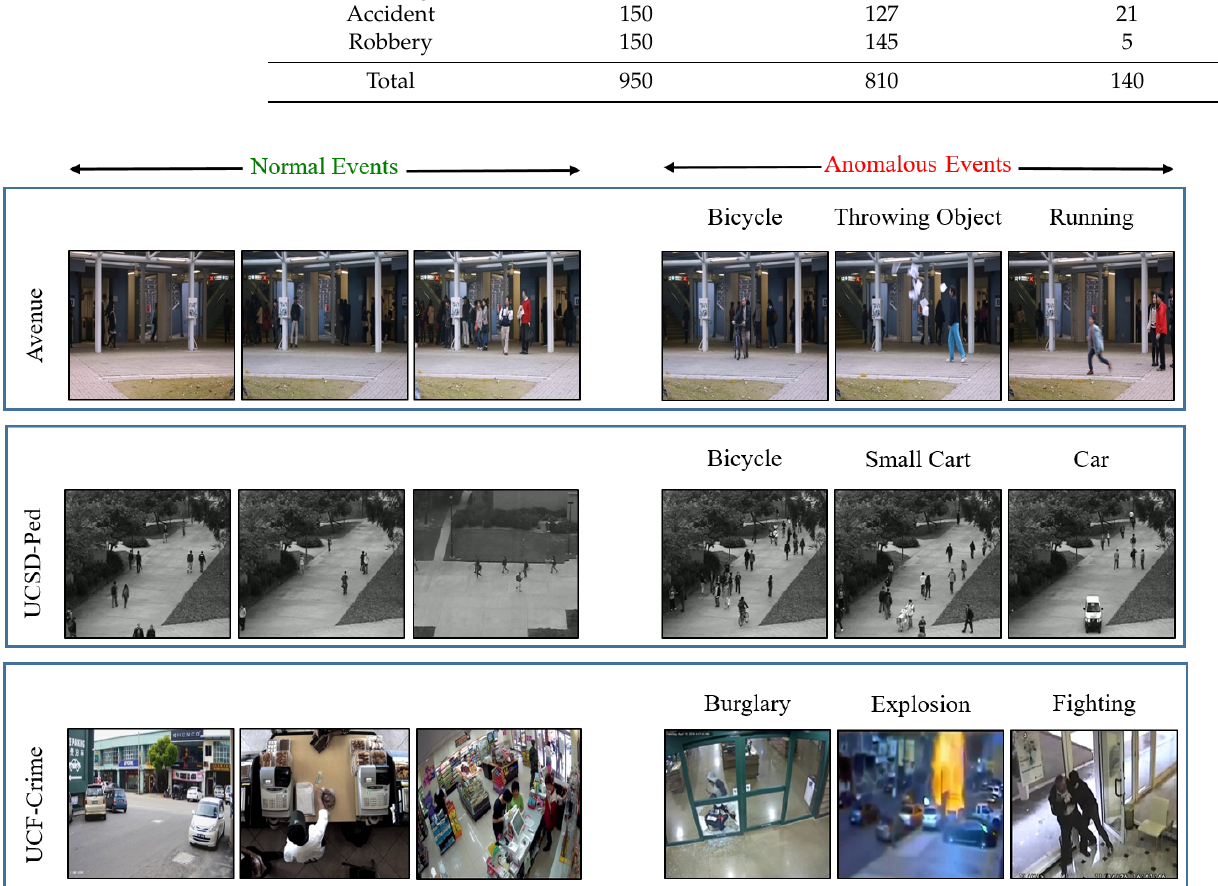
Figure 3. Sample of the ‘Normal’ and ‘Abnormal’ event frames from three datasets: Avenue, UCSD (Ped1 and Ped2), and